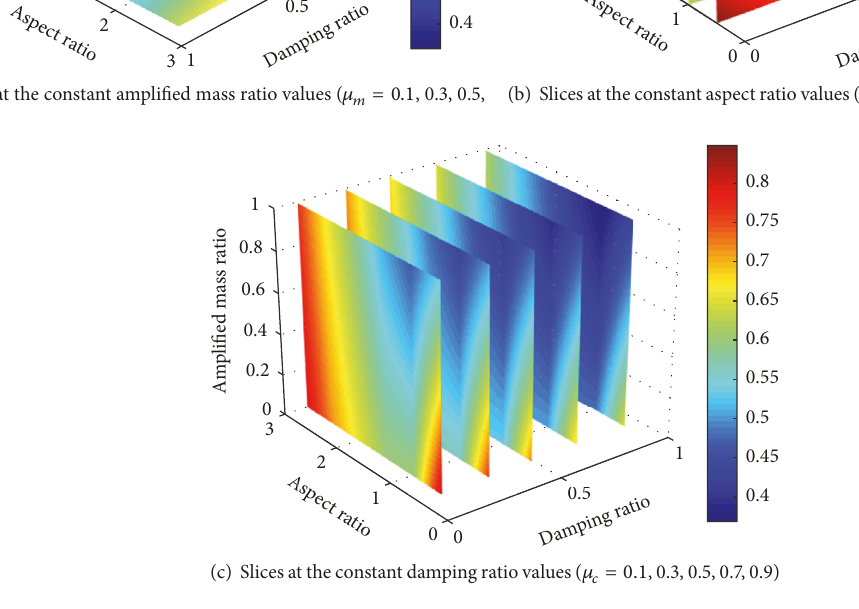
(c) Slices at the constant damping ratio values ( 𝜇 𝑐 = 0.1 , 0.3, 0.5, 0.7, 0.9) Figure 3: Sloshing height ratio 𝛾 𝑠 in the 𝜇 𝑐 , 𝜇 𝑚 , 𝑠 space of the storage tank with the